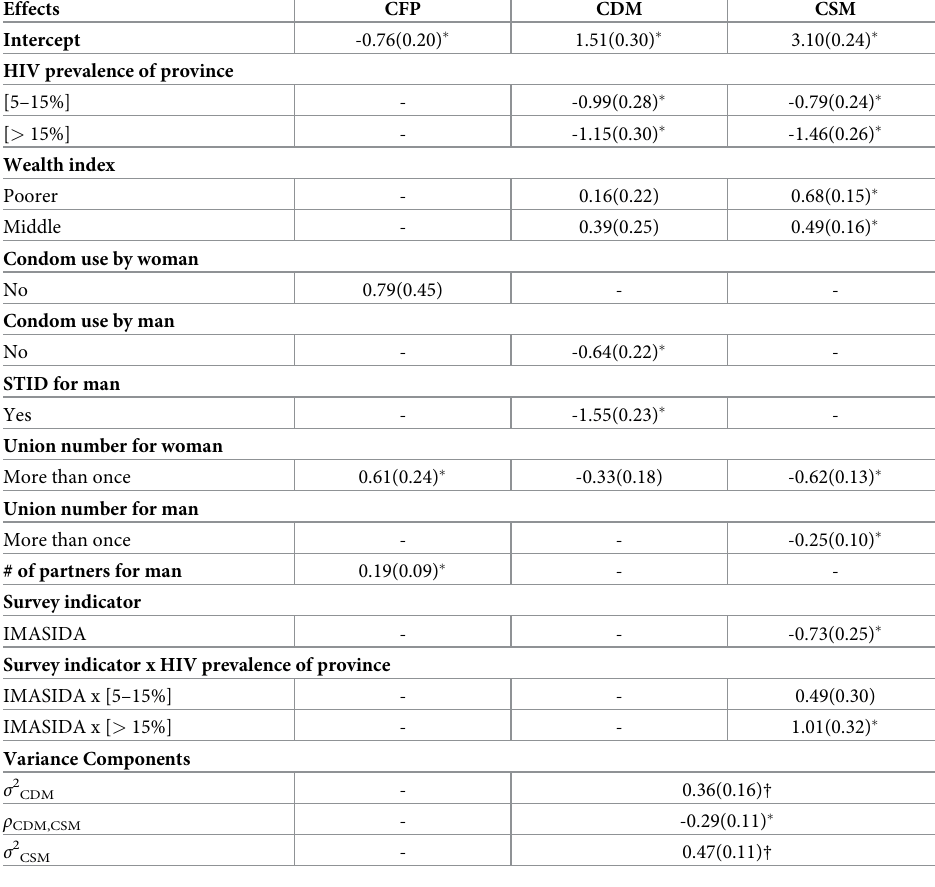
Table 3. Estimates (standard errors) of the final model with partial-correlated random effects ( b CDM, i , b CSM, i ) with and no random effect ( b CFP, i